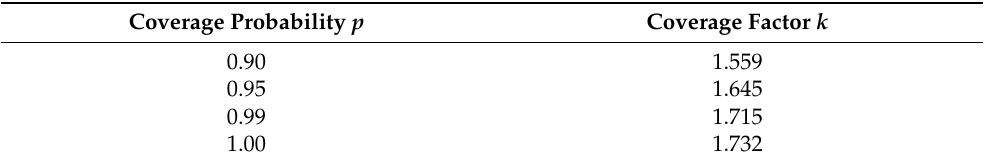
Table 1. Values of the coverage factor k that produces an interval with the coverage probability p assuming a rectangular distribution.